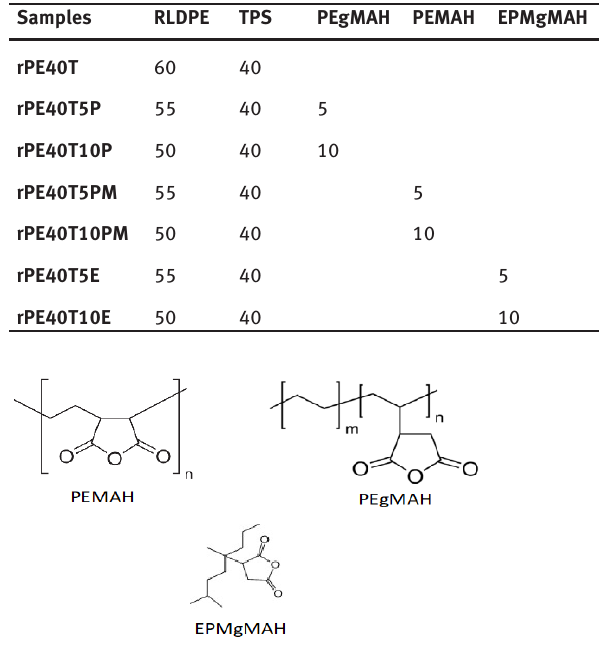
Table 1: Compositions of the Prepared Blends. Samples